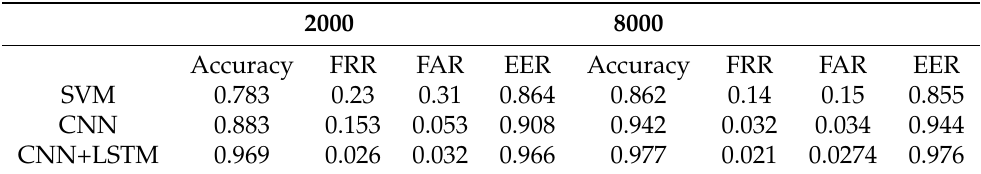
Table 9. Certification effect of the three methods after training on different numbers of datasets.